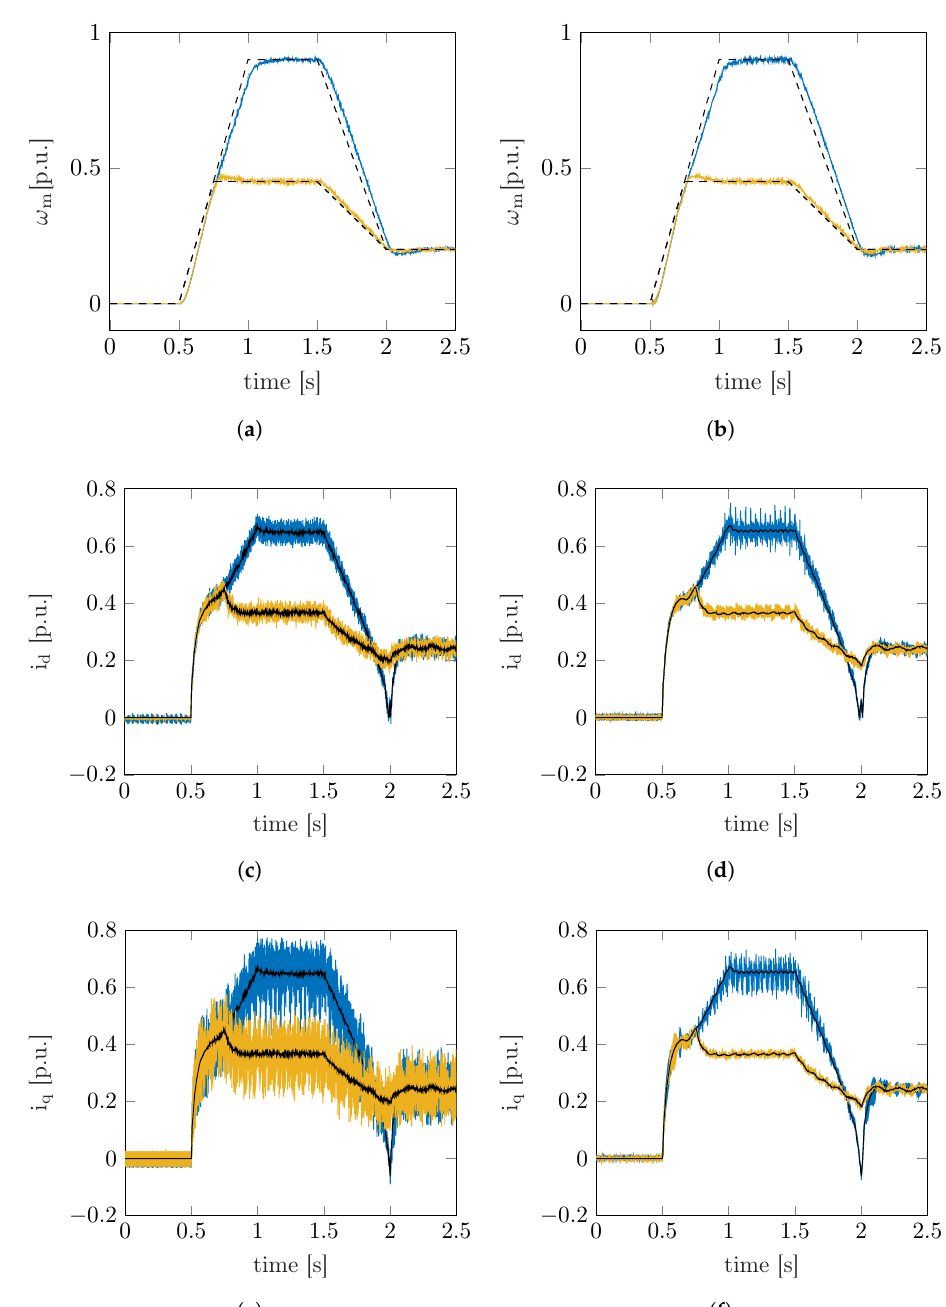
Figure 6. Pump load emulation results of the motor under test SynRM 2 . Figures ( a , c , e ) report the results of model-free FS-PCC [25]; Figures ( b , d , f ) report the results of the proposed model-free